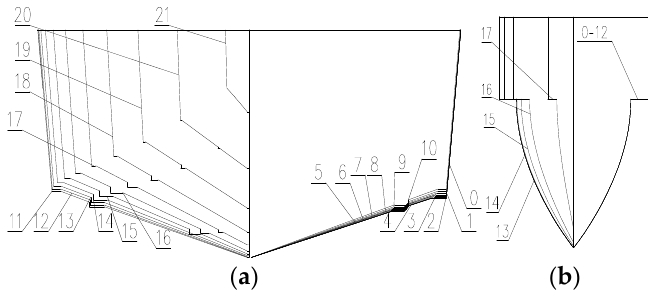
Figure 2. Molded lines of the model: ( a ) main hull; ( b ) side-hull. Table 1. Primary geometric details of the planing hull at each navigation state.